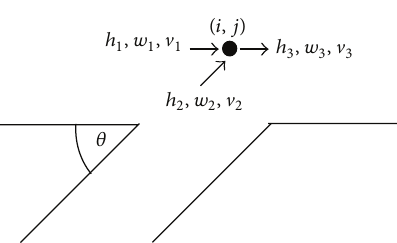
Figure 2: Illustration of the inelastic collision of two river branches.